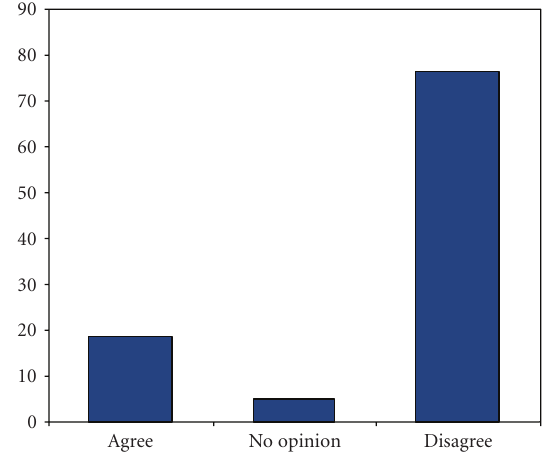
Figure 1: Answers of Belgian gynaecologists concerning a “nulli- parous woman of 38 years, pregnant through IVF after 4 attempts and requesting a prelabour caesarean